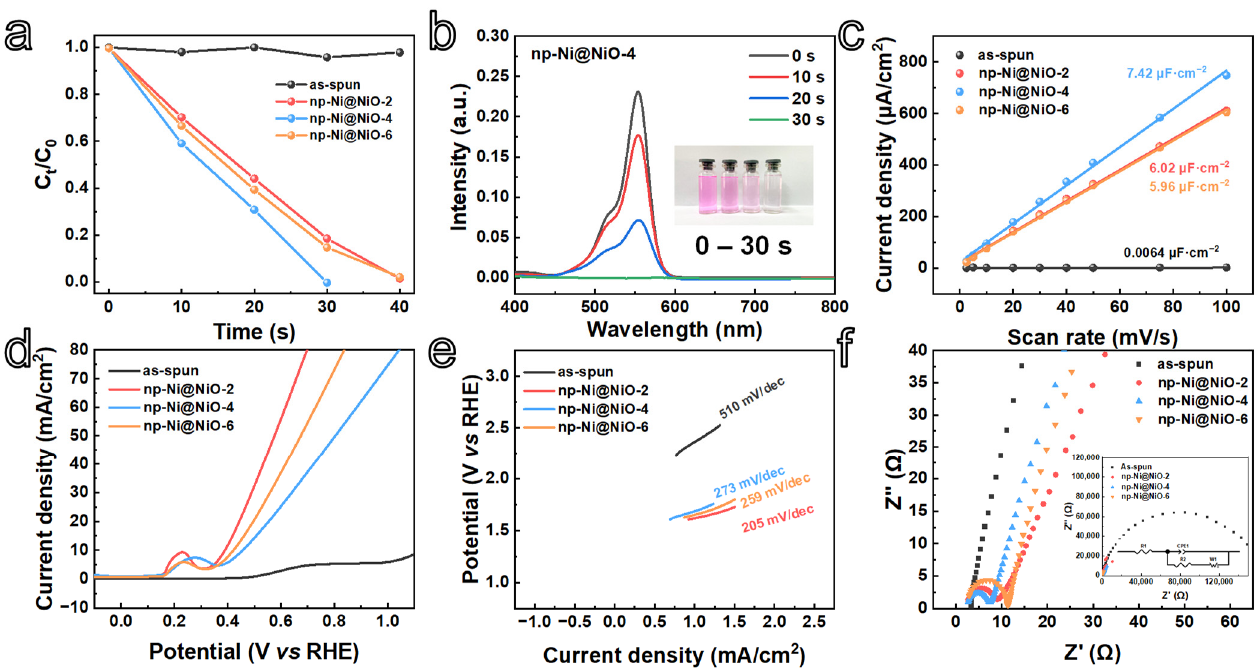
Figure 3. ( a ) The electrochemical degradation of RhB for different catalysts (0.01 M NaCl concentration, 1.5 V applied potential and initial pH 7). ( b ) UV absorption spectra of RhB solutions under various times at np-Ni@NiO-4 electrode. ( c ) Current density differences at 0.05 V (vs Ag/AgCl) plotted against the scan rate measured in a non-Faradaic range. ( d ) LSV curves measured at 5 mV s − 1 in 1 M KOH. ( e ) Tafel plots derived from LSV curves. ( f ) The Nyquist plots of the electrode materials in 0.5 M Na 2 SO 4 .